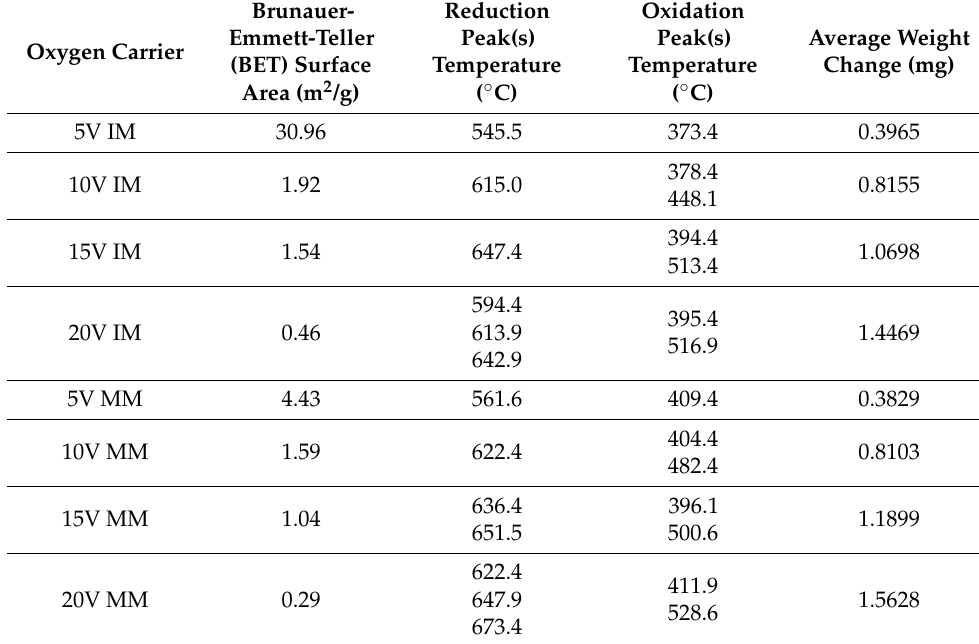
Table 1. The BET surface area and quantitative results of thermogravimetric (TGA) analysis.